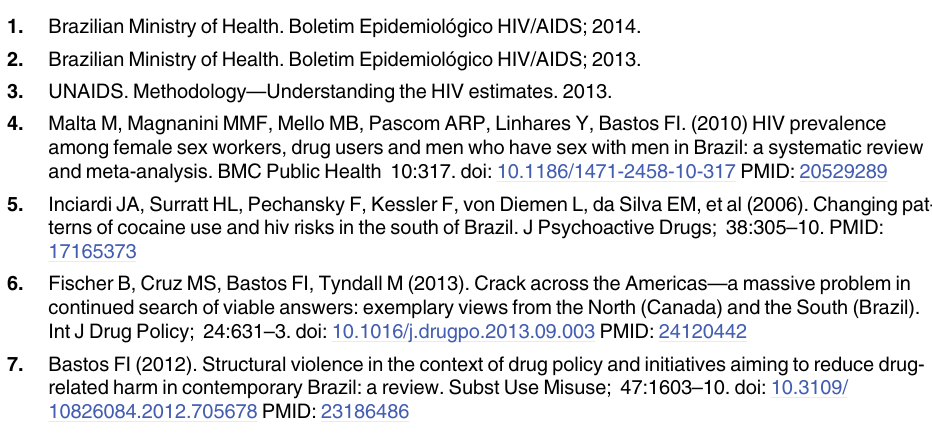
S2 Fig. Phylogenetic tree analysis of the 132 HIV-1 positive individuals identified by RDS based on the C2-V3 env region. The phylogenetic inferences were performed by the ML algo- rithm under GTR+I+ Γ 4 nucleotide substitution model using MEGA v6.0 package. The scale represents number of substitutions per site. The color of the branches represents the Brazilian States from where the individual ’ s sequences originated, according to the legend in the figure. aLRT superior than 0.90 were depicted. S3 Fig. Schematic drawing showing breakpoint patterns of all HIV-1 recombinant patterns detected in the analyses of the env- C2-V3 (6922 – 7277 relative to the HXB2) and pol-PR/RT (2265 – 3519 relative to the HXB2) regions Breakpoint positions were obtained using boot- scanning and informative site analysis for intragenic recombinant sequences. The studied regions were colored according to the subtype as shown in the figure legend. The fragments not analyzed are represented in white. Genomic structures were drawn by using the Recombi- nant Draw Toll available in the Los Alamos homepage (http://www.hiv.lanl.gov/content/hiv-